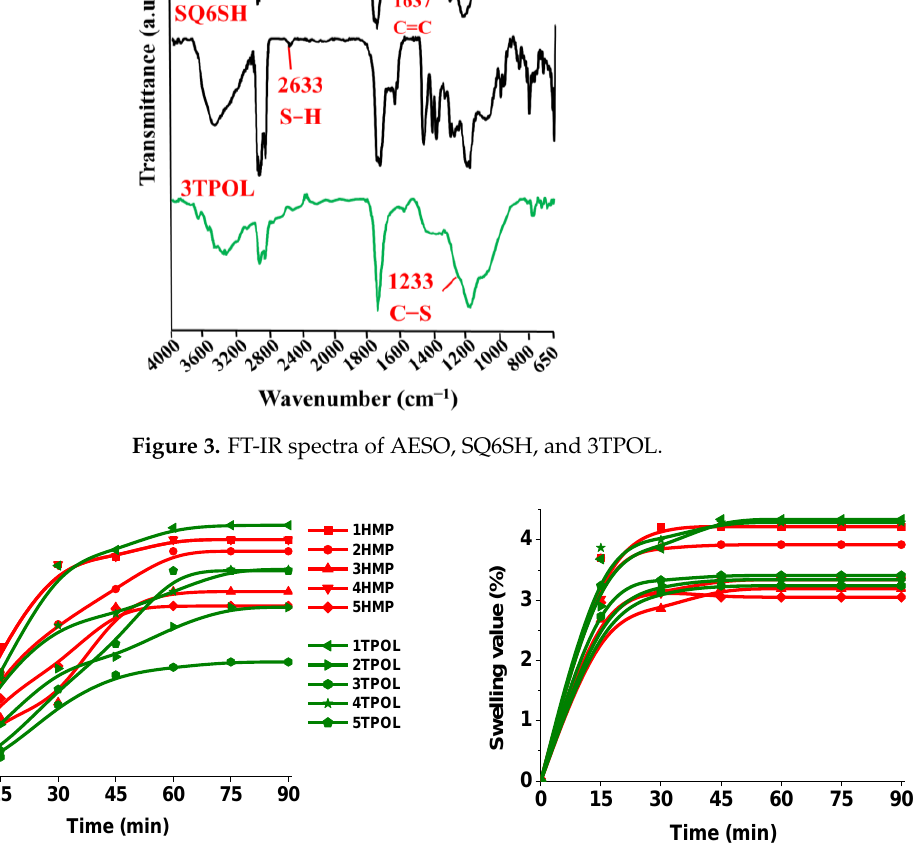
Figure 3. FT-IR spectra of AESO, SQ6SH, and 3TPOL.